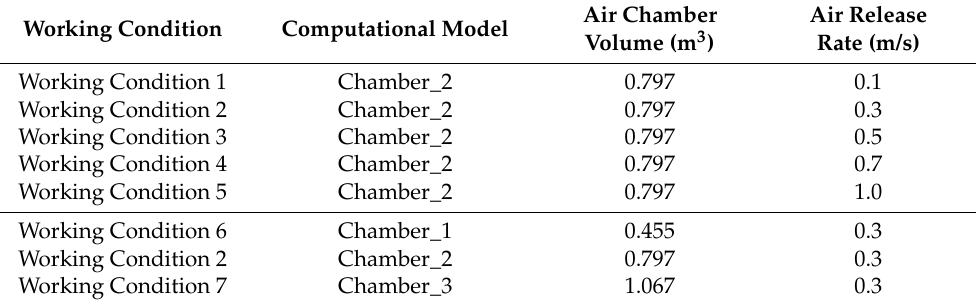
Table 1. Working conditions.